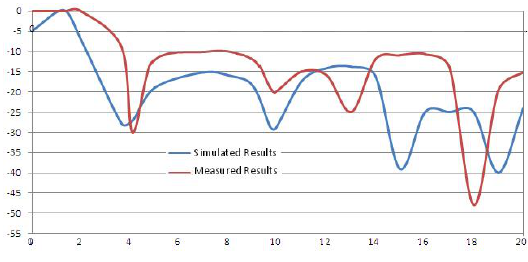
Figure 10: Comparison of measured and simulated results of de- sired antenna on vector network analyser.